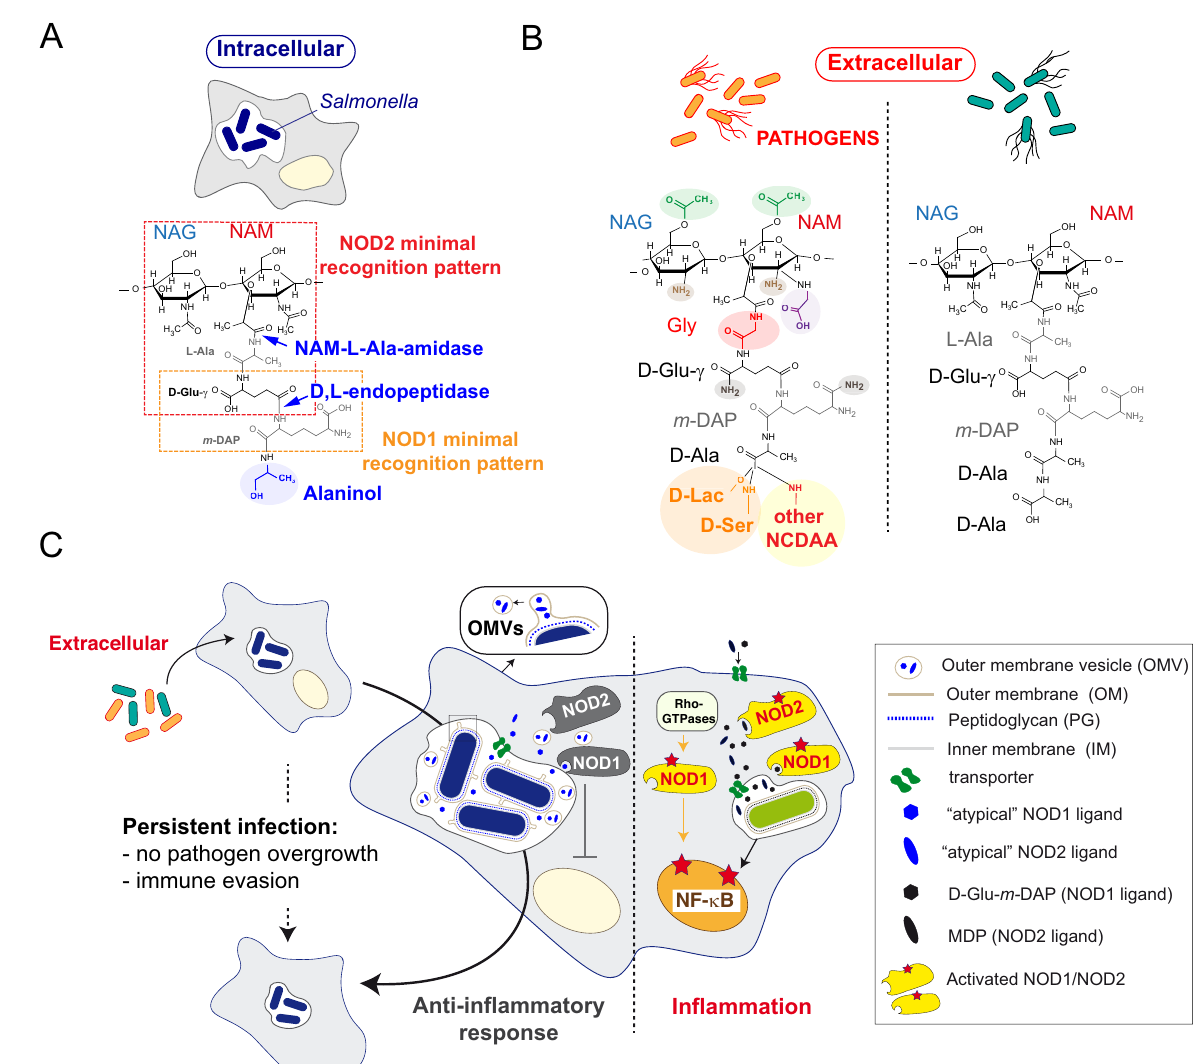
Fig 8. Working model depicting how PG editing in non-proliferating intracellular S . Typhimurium interferes with immune signaling and promotes persistence. (A-B) Comparison of structural alterations identified in the PG of intracellular S . Typhimurium versus those reported in other pathogens under laboratory conditions and the structure of a canonical muropeptide of Gram-negative bacteria (extracellular); (C) Scheme that shows how the release from intra-phagosomal S . Typhimurium of outer membrane vesicles having as cargo atypical PG fragments, like those containing D-alaninol, could favor immune evasion and persistence by interfering with NOD1/NOD2 responses. The model compares such event with an infection in which S . Typhimurium releases pro-inflammatory (canonical) PG fragments that stimulate NF- κ B. The model also integrates the NOD1 activation by pathogen effectors that target Rho-GTPases independently of PG fragments reported by others [77]. How the PG fragments are transported from the phagosome or vesicles to the cytosol remains poorly understood. NAG: N -acetylglucosamine, NAM: N - acetylmuramic acid, m- DAP: meso -diaminopimelic acid; D-Ser: D-serine, D-Lac: D-lactate, NCDAA: non-canonical D-amino acid; OMV: outer membrane vesicles.